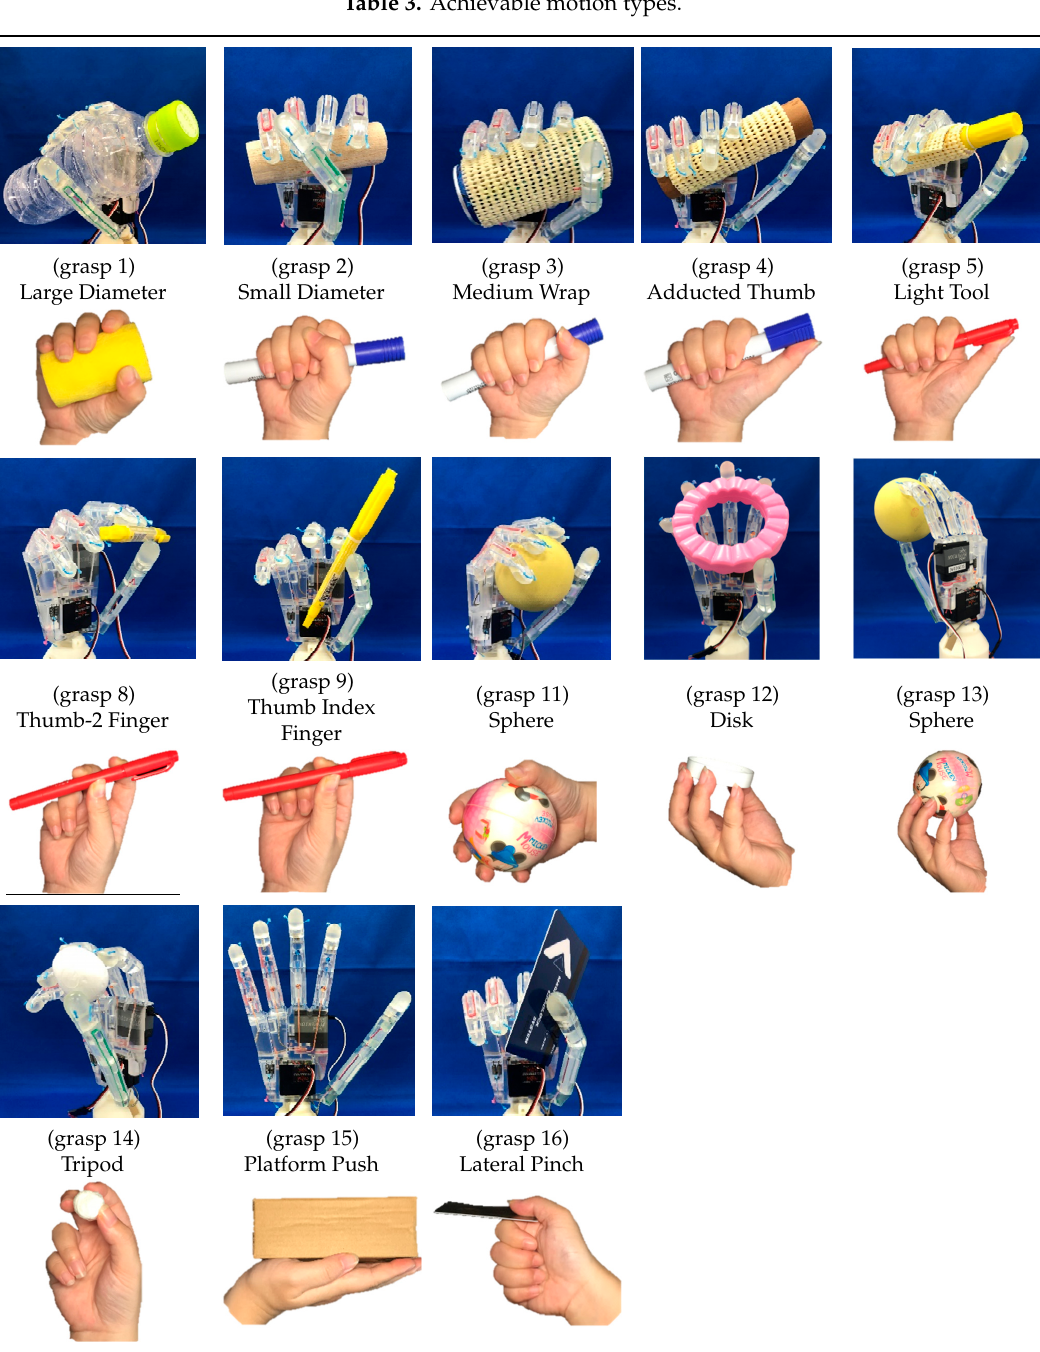
Table 2. List of experimental objects.